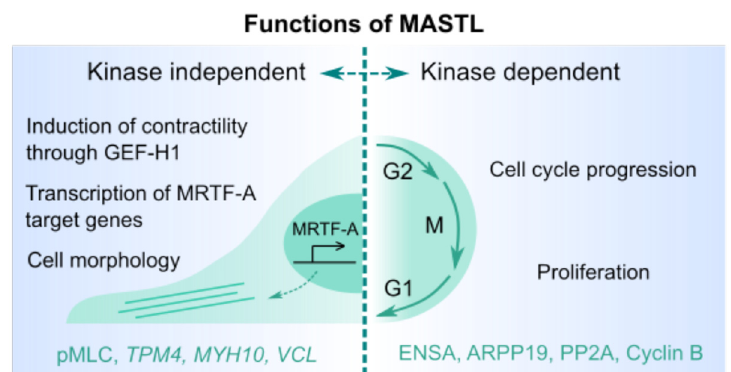
Figure 2. Illustration of known MASTL functions. The divisions between kinase-dependent and -independent functions are suggestive and need to be studied further.